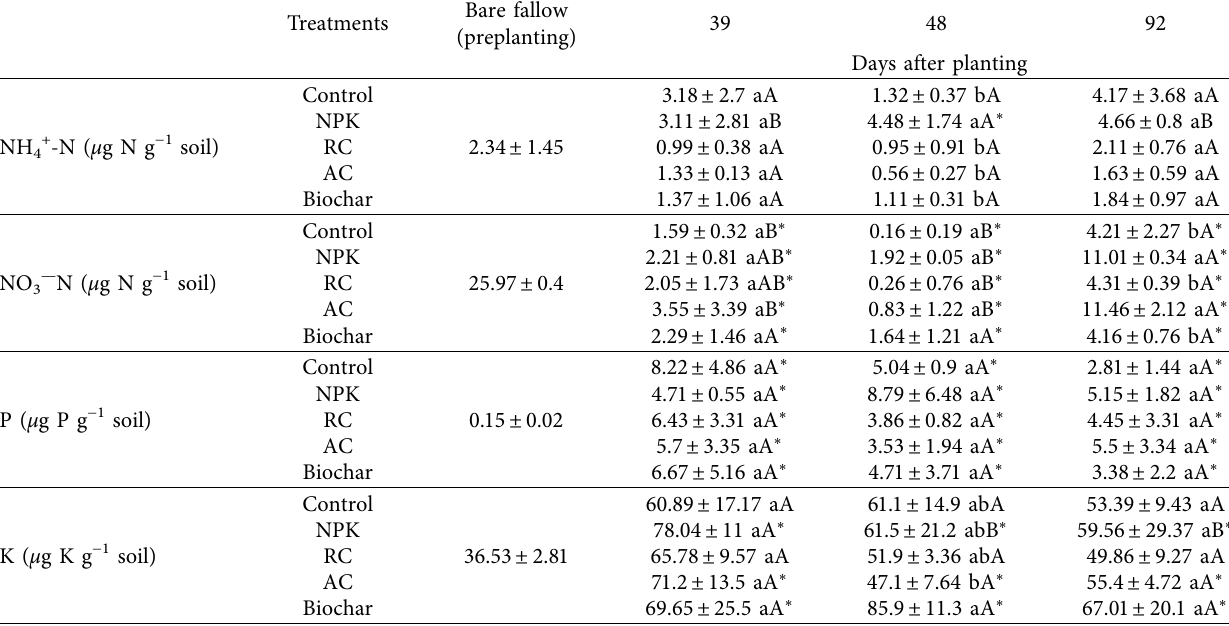
Table 3: Soil concentrations of available N, P, and K during the growing season of sweet potatoes at preplanting and 39, 48, and 92 days after planting.